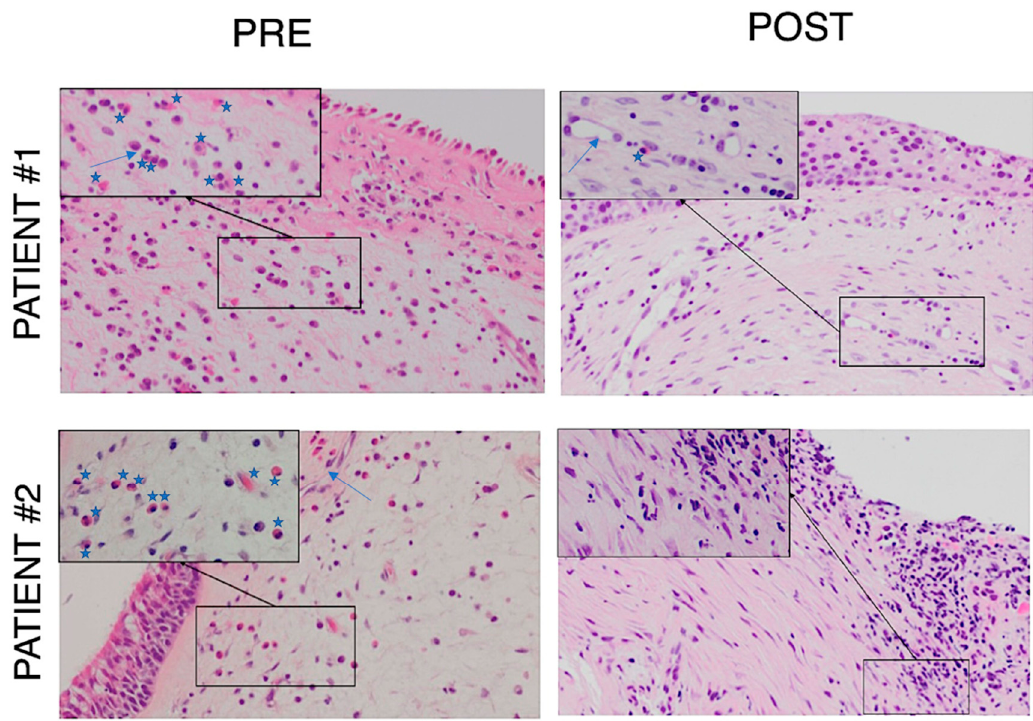
Figure 3. PRE: Histological samples 2 months prior to surgery (PRE), showing typical EGPA peri- vascular eosinophilic pattern (patient #1: 10/HPF; patient #2: 12/HPF). POST: Histological samples 12 months after reboot surgery depict markedly reduced eosinophilic infiltration ( ≤ 1/HPF); objective magnification at 20 × (at 40 × in the boxes); star: eosinophil, arrow: